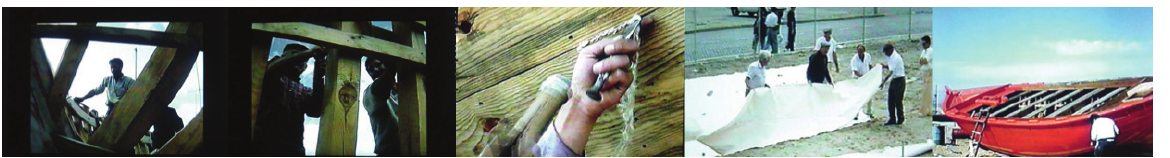
Figure 4: Construction Stages of “lancha Poveira”